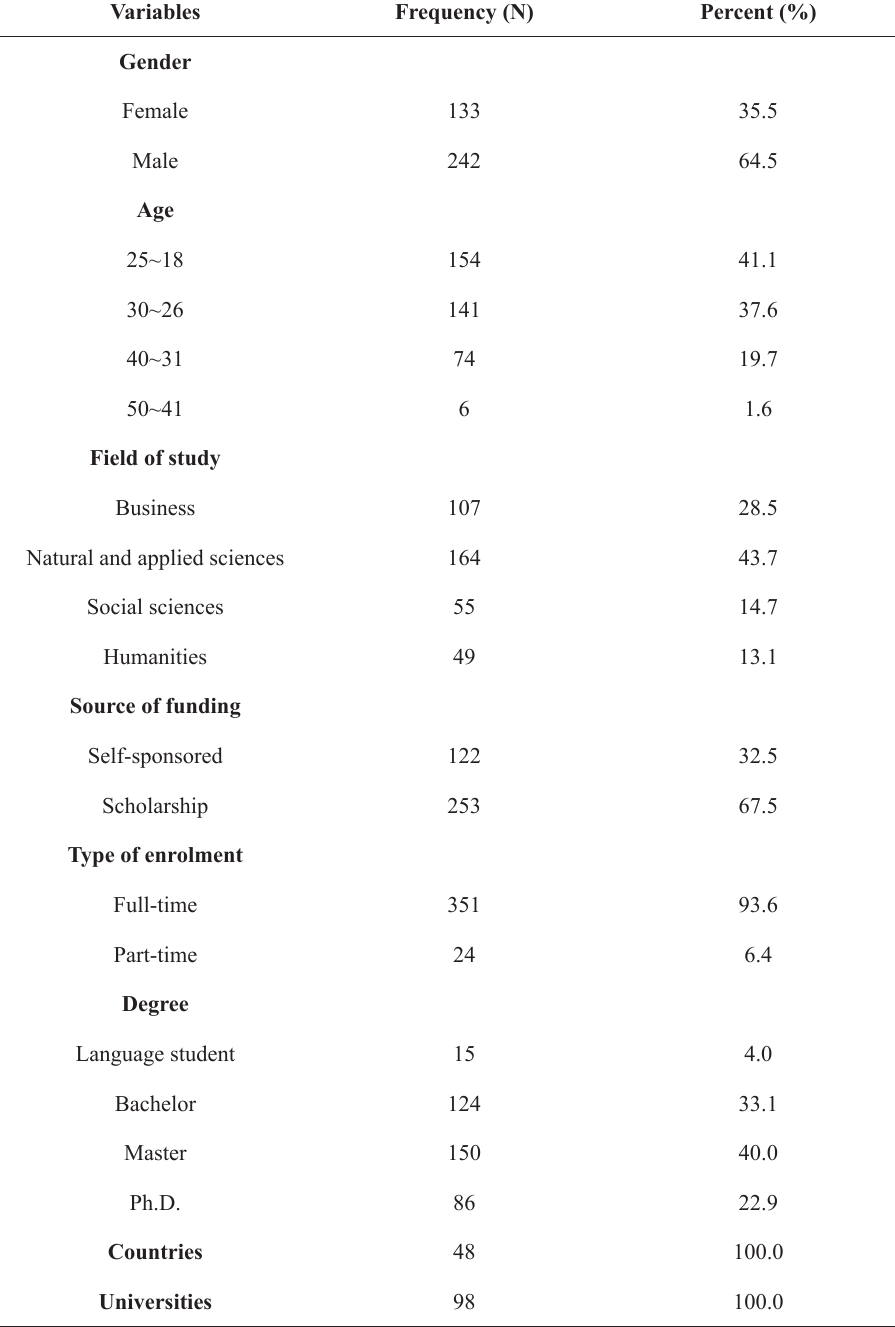
Table 1. Demographic profile of the quantitative sample (N =